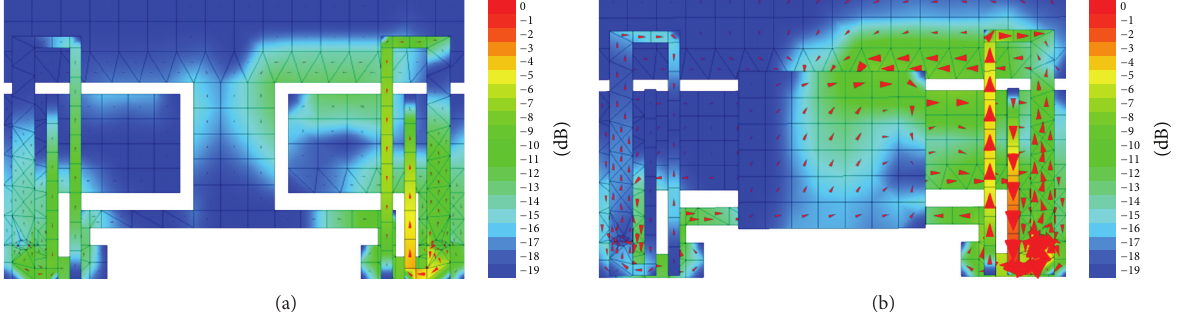
Figure 6: Front view of the antenna. Surface current distributions at 2.350 GHz when Port 1 is excited. (a) Without the rectangular patch. (b) With the rectangular patch.